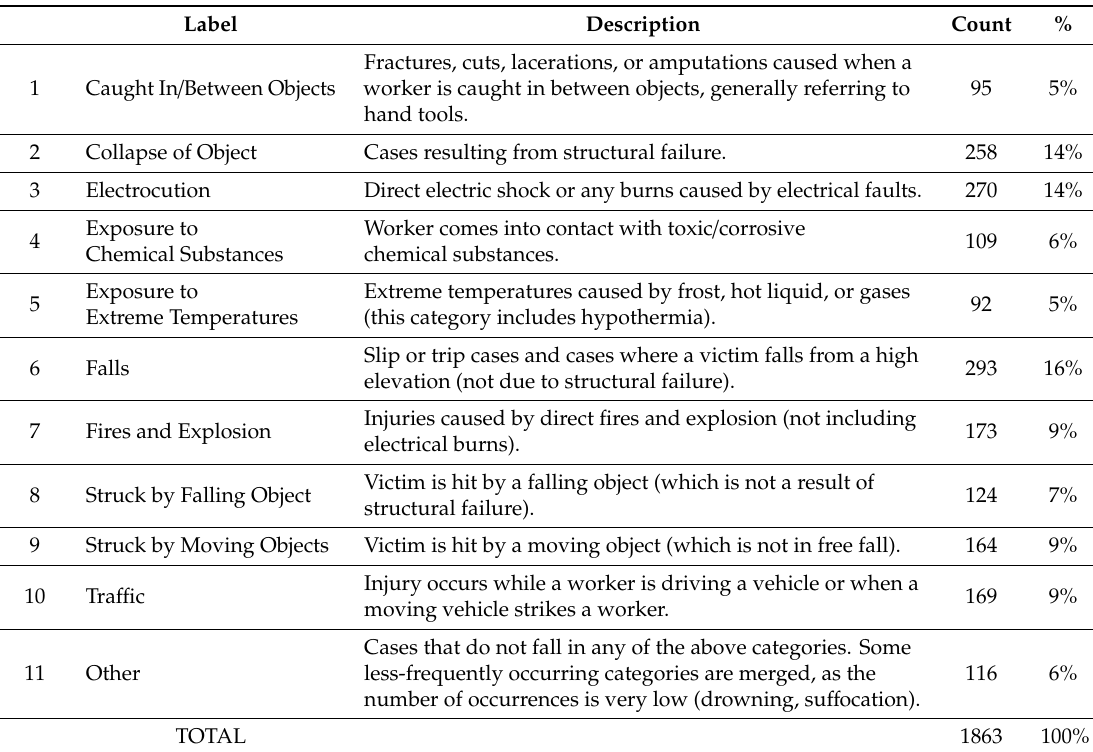
Table 2. Labels and sample distributions used in this